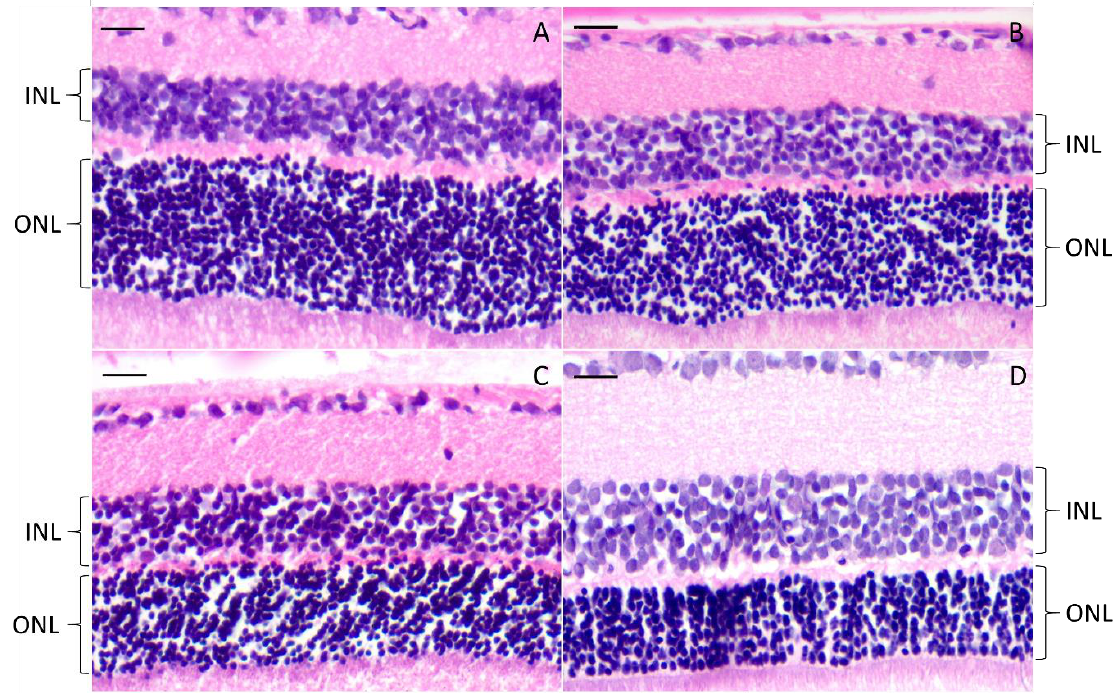
Figure 12. Effect of rhCNTF treatment on the morphology of the retina. Histological analysis of retinal sections did not show clear benefit of treatment with 1 µ g rhCNTF ( a ) compared to internal control sections did not show clear benefit of treatment with 1 µg rhCNTF ( a ) compared to internal control ( b ), Bu ff er M control ( c ), and Ncontrol ( d ). Scale bar 20 µ m. INL, inner nuclear layer; ONL, outer ( b ), Buffer M control ( c ), and Ncontrol ( d ). Scale bar 20 µm. INL, inner nuclear layer; ONL, outer nuclear nuclear layer.